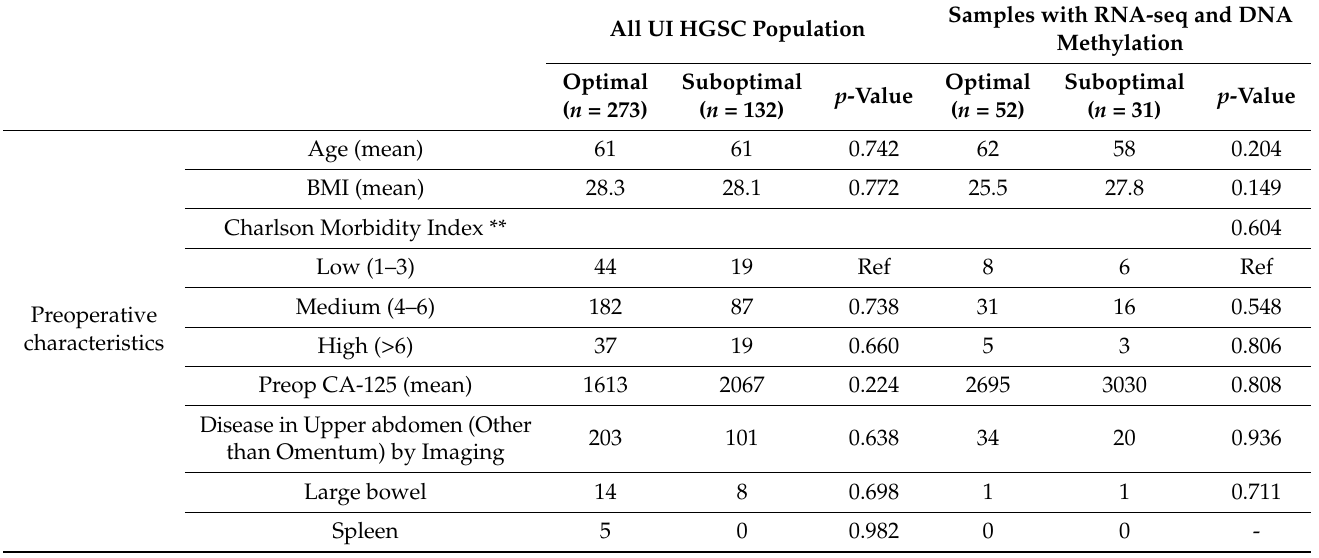
Table 1. Patient Characteristics and Association with PCS Outcome. Samples with RNA-seq and All UI HGSC Population